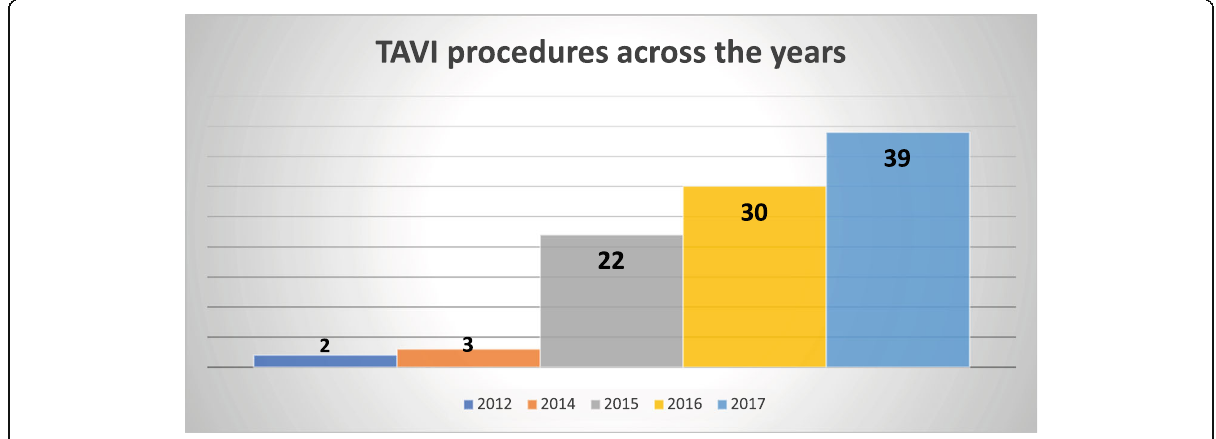
Fig. 2 TAVI procedures across the